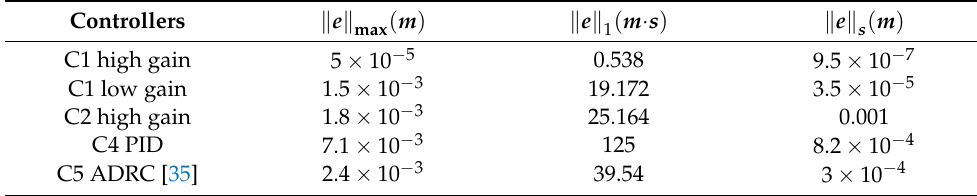
Table 2. Numerical comparison of tracking errors.